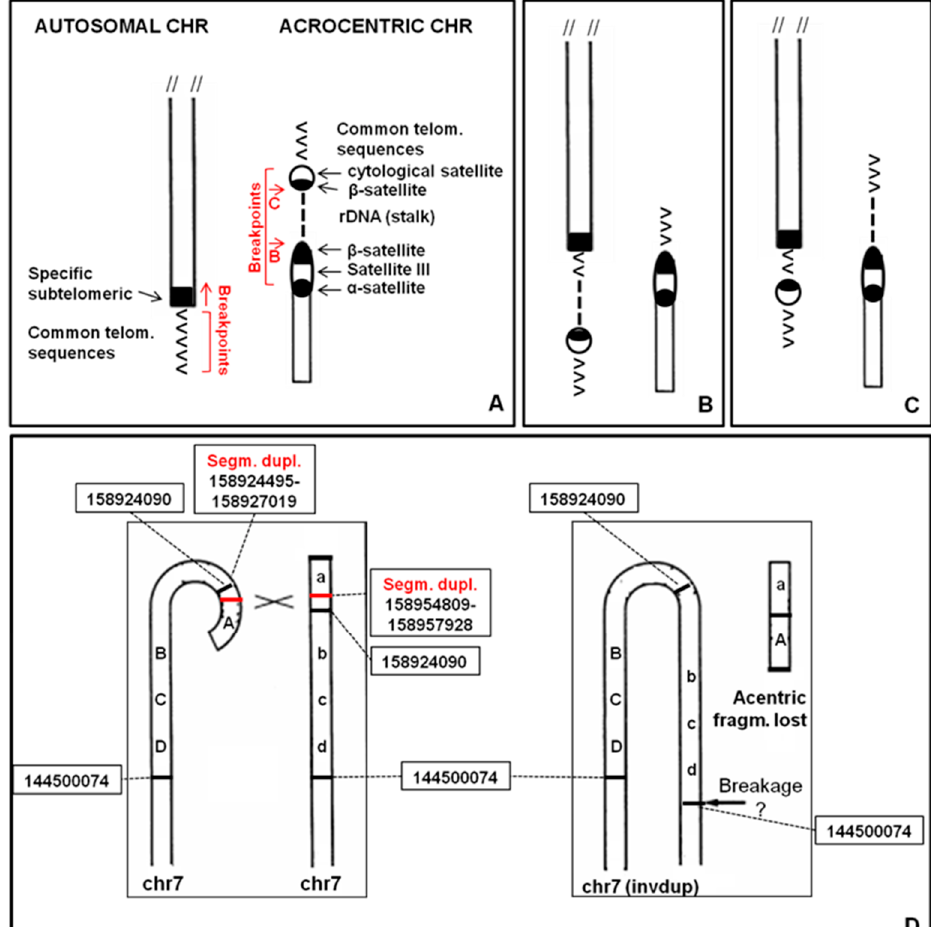
Figure 7. Causative mechanisms of ps–qs formation. ( A ) homologous repetitive sequences in telomeric regions and acrocentric chromosomes; ( B ) first type of non-allelic homologous recombination (NAHR) (cases 4qs, 5qs, 17qs, 20ps, 20ps and 21ps); ( C ) second type of NAHR (cases 4qs, 9qs and 14qs); ( D ) 7qs complex rearrangement (invdup?) mediated by segmental duplications. Black lines: breakpoints, red lines: segmental duplications.